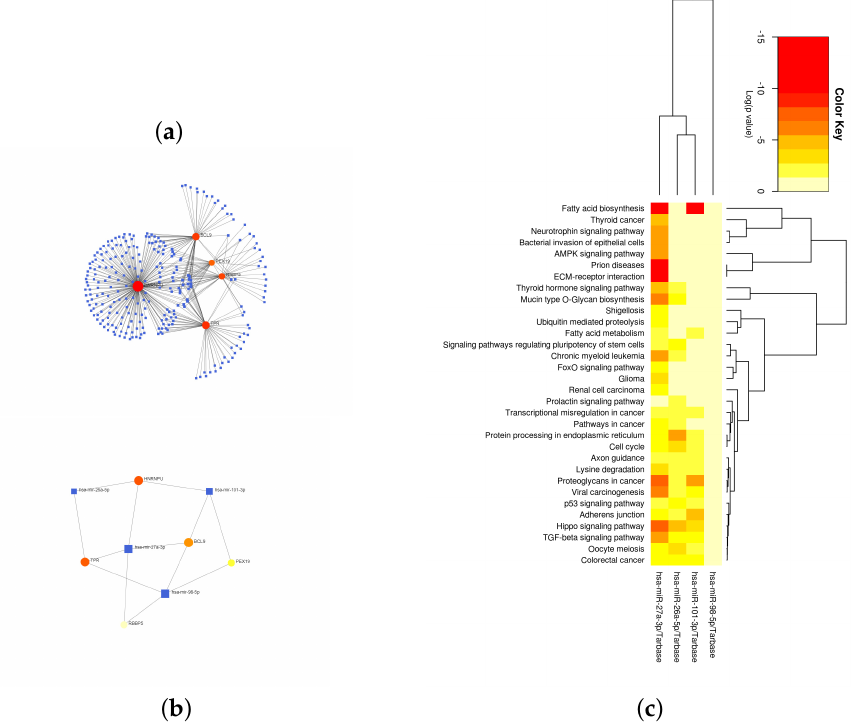
Figure 6. MiRNAs associated with the five hub genes. ( a ) The gene–miRNA interaction network of the five hub genes. ( b ) The minimal network of the gene–miRNA interaction networks of the five hub genes. ( c ) A heat map of the miRNA enrichment analysis